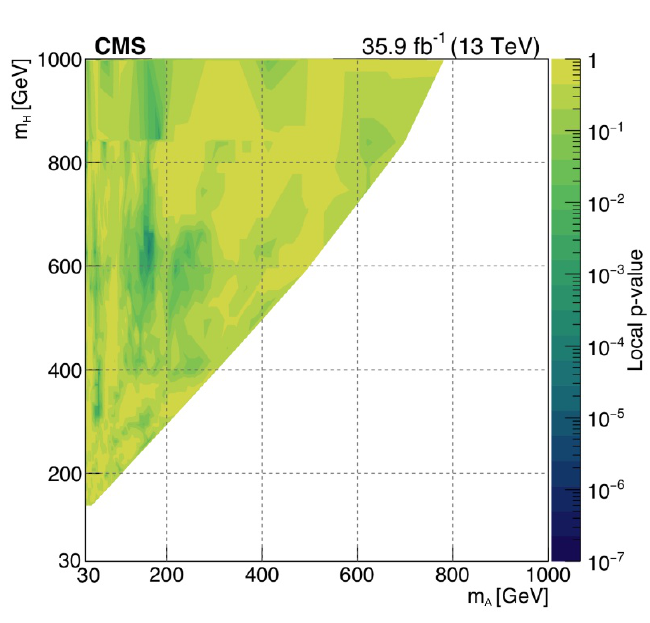
Figure 7 . Expected (left) and observed (right) 95% CL upper limits on the product of the pro- duction cross section and branching fraction (cid:27) B for H(A) ! ZA(H) ! ‘‘ bb as a function of m and m . The limits are computed using the asymptotic CL H